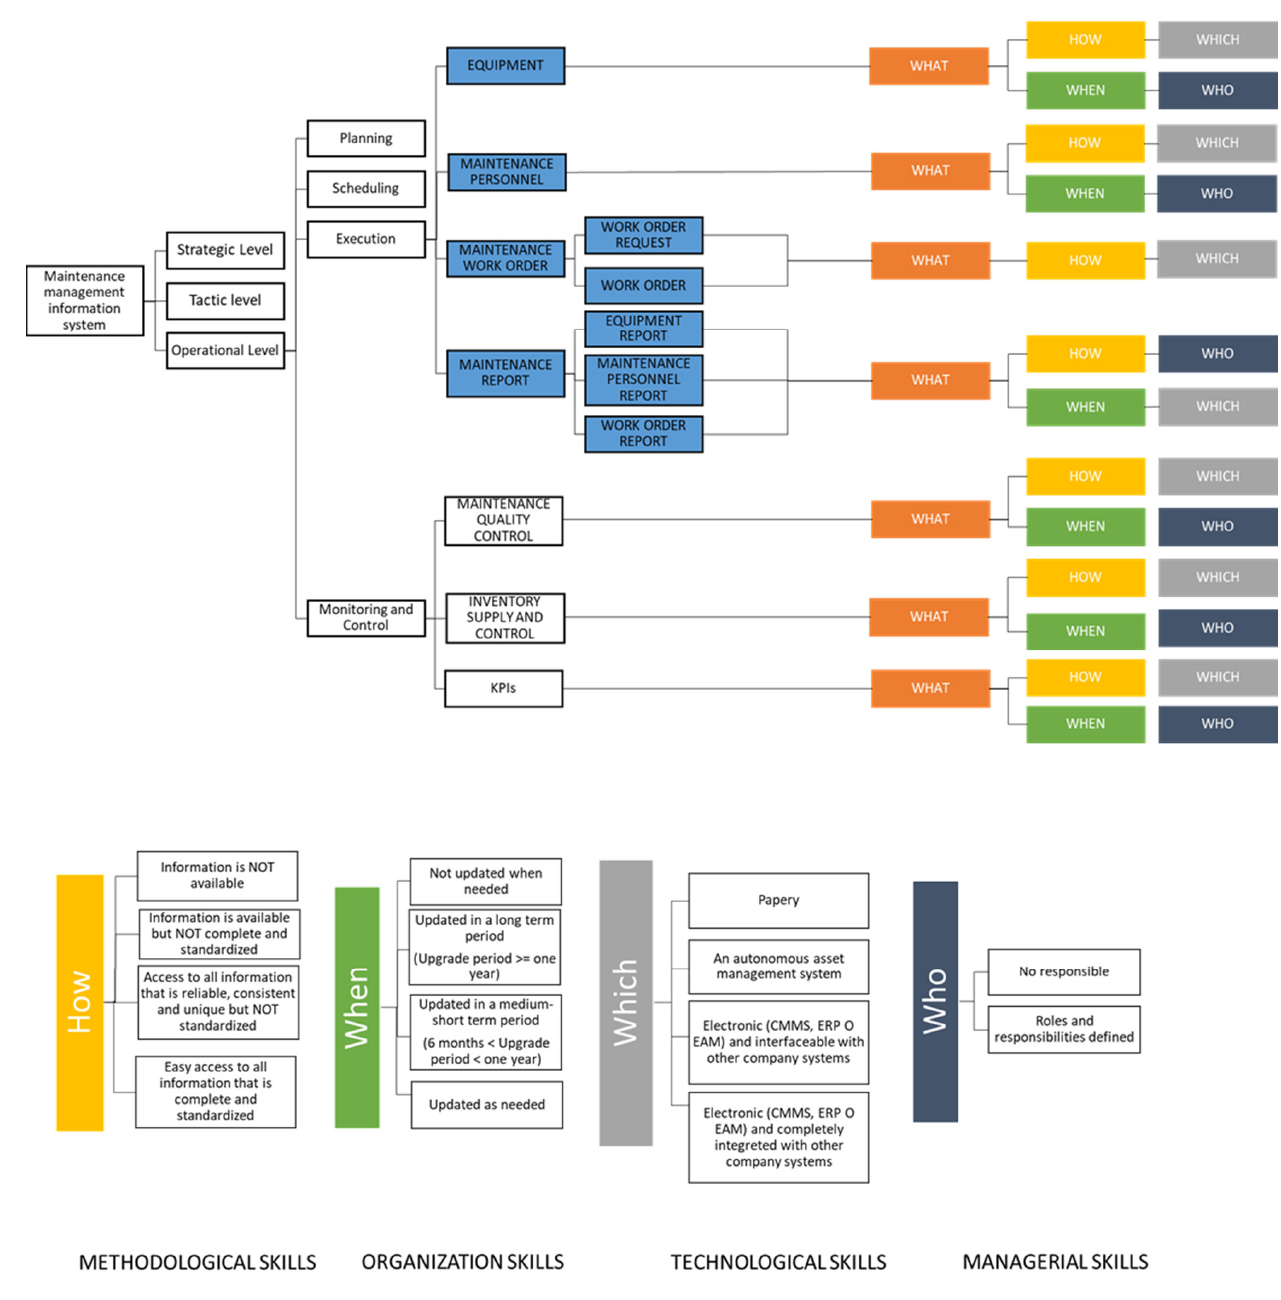
Figure 4. The M 3 AIN4SME architecture.